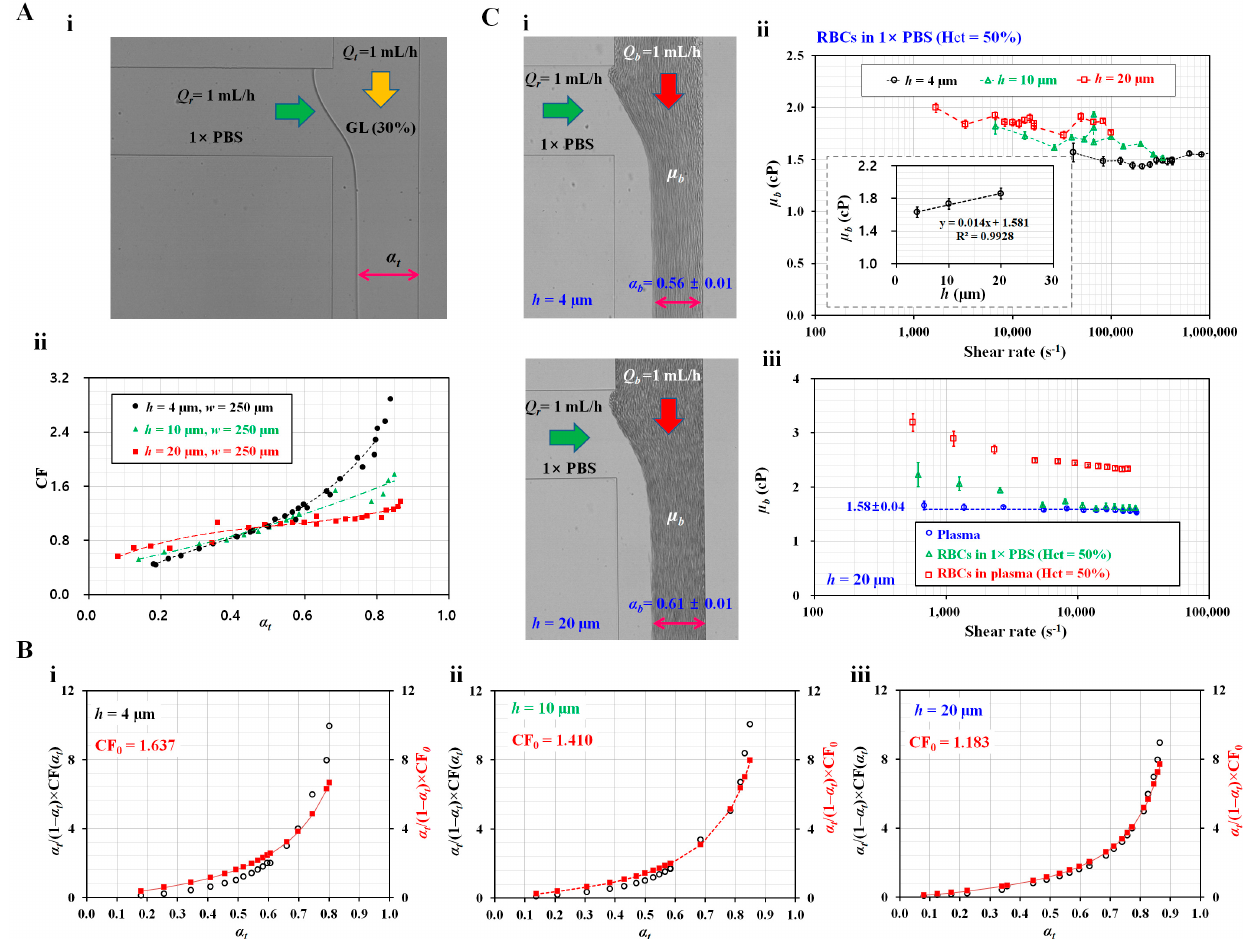
Figure 2. Contribution of channel depth ( h ) to blood viscosity under steady flow. ( A ) Quantification of correction factor with respect to channel depth. ( i ) Microscopic image showing interface of two fluids (i.e., test fluid: glycerin solution [30%], reference fluid: 1 × PBS) in the coflowing channel, at the same flow rate (i.e., Q r = Q b = 1 mL/h); α t denotes the interface. ( ii ) Variations of correction factor (CF) with respect to channel depth ( h = 4, 10, and 20 µ m) and interface ( α t ). ( B ) Approximation of α t /(1 − α t ) × CF ( α t ) as α t /(1 − α t ) × CF 0 with respect to channel depth ( h ) ([ i ] CF 0 = 1.637 for h = 4 µ m, [ ii ] CF 0 = 1.41 for h = 10 µ m, and [ iii ] CF 0 = 1.183 for h = 20 µ m). ( C ) Variations of blood viscosity ( µ b ) with respect to channel width. ( i ) Microscopic images showing interface with respect to h = 4 and 20 µ m. ( ii ) Contribution to channel depth to µ b . Blood (Hct = 50%) was prepared by adding normal RBCs into 1 × PBS. The inset shows variations of µ b with respect to h . ( iii ) Variations in viscosity of blood (plasma, normal RBCs in plasma, and normal RBCs in 1 × PBS) with respect to shear rate. Here, channel depth was set to 20 µ m. Hematocrit was fixed to 50%.